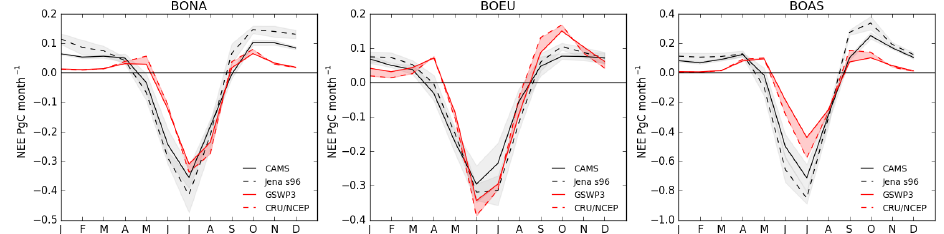
Figure 19. Monthly mean seasonal net land–atmosphere CO 2 fluxes (NEE in PgC month − 1 ) from the GSWP3 and CRUNCEP-forced simulations compared to atmospheric inversions, over the three high-latitude sub-regions (shown in Fig. 2a), averaged over the period 2000– 2007. The grey shaded areas correspond to the SD of the monthly values for each inversion. Note that a negative sign in NEE corresponds to CO 2 uptake from the atmosphere, and a positive sign to release into the